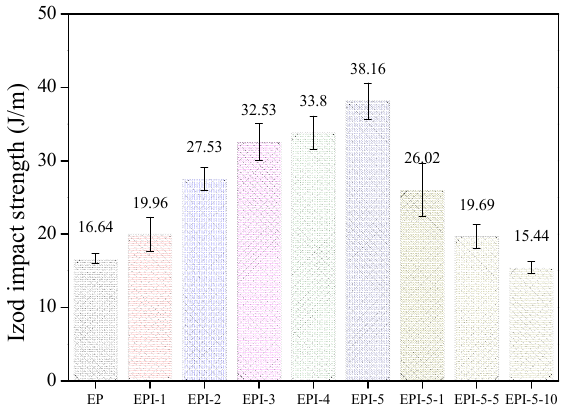
Figure 7. Izod impact strengths of cured epoxy/polyimide blend